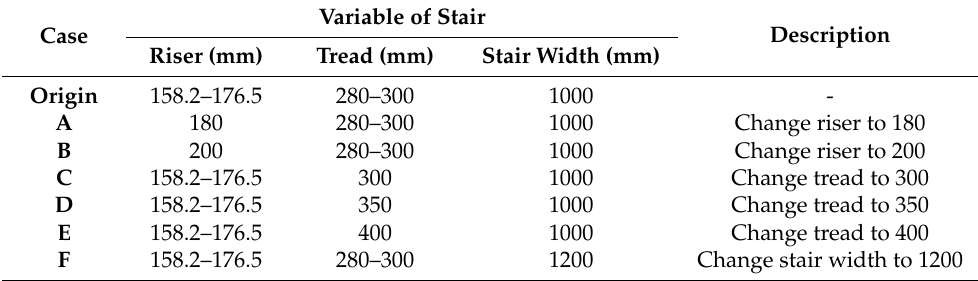
Table 7. Defining Variable Values by